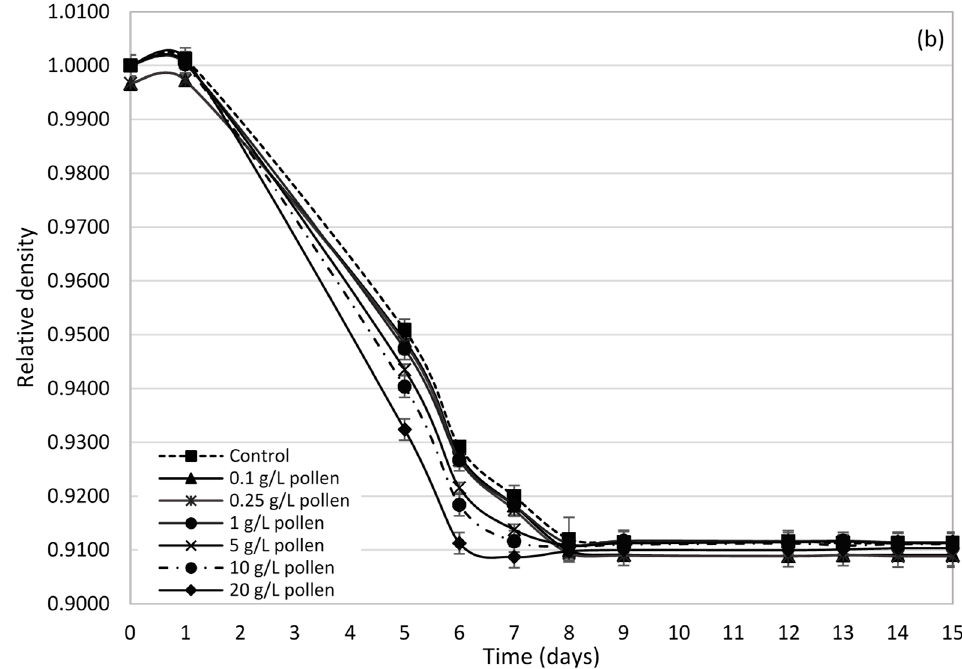
Figure 1. Relative density evolution in Palomino fino ( a ) and Riesling ( b ) grape musts during alcoholic fermentation with the addition of different bee pollen doses.